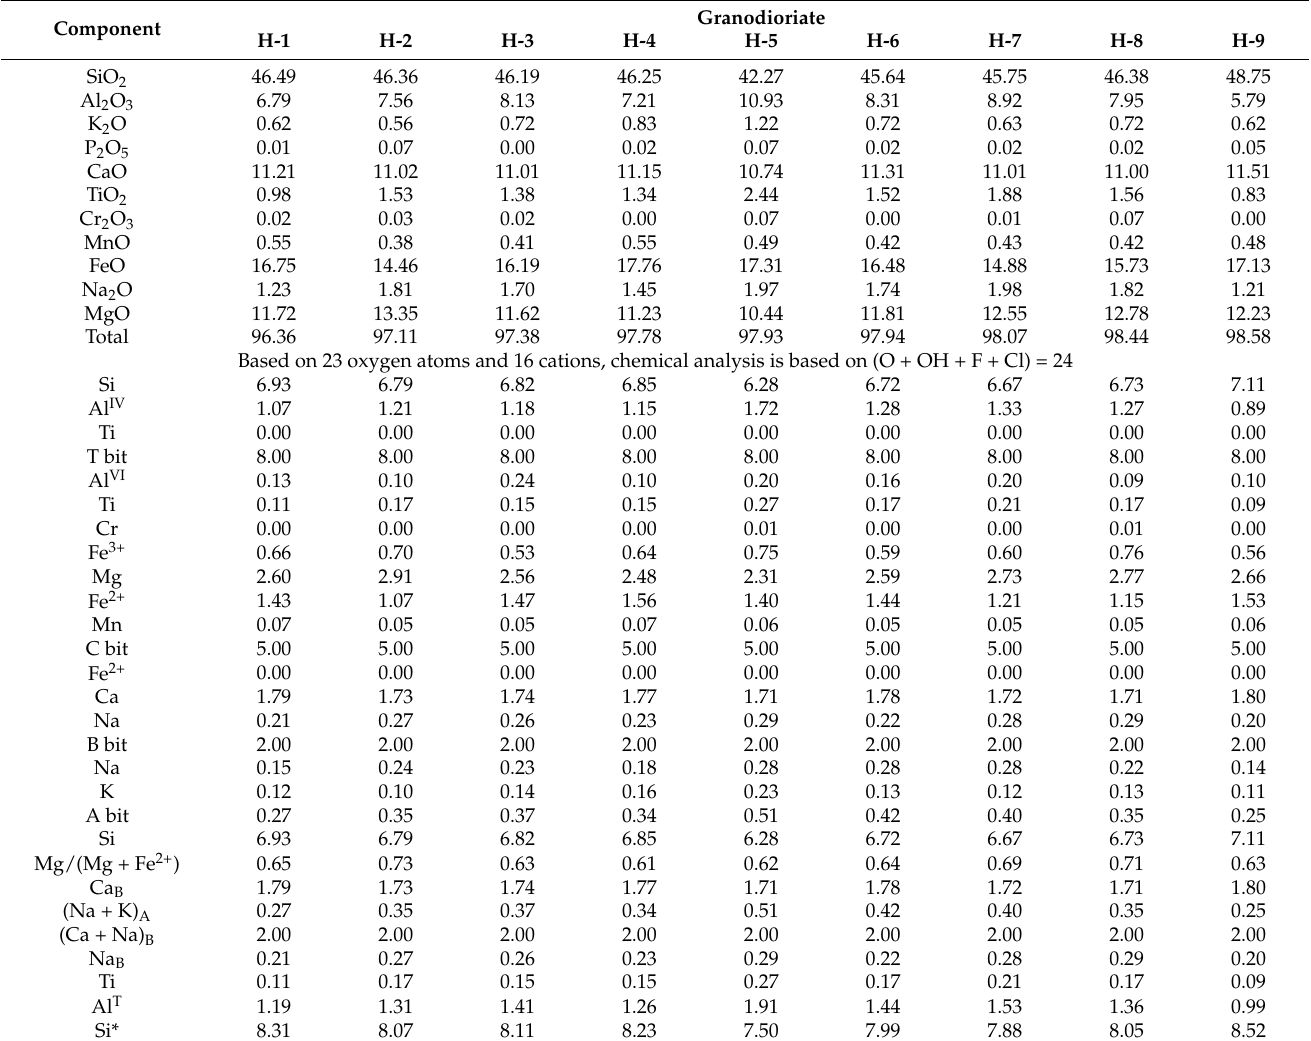
Table 5. Composition of the amphiboles in Zhouguan